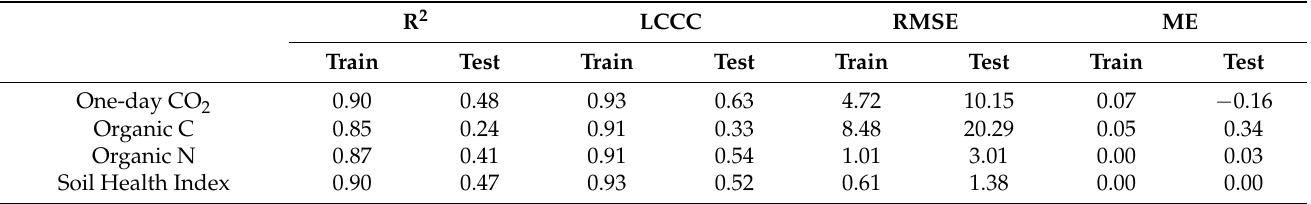
Table 3. Performance evaluation of prediction model on train (75%) and test (25%) dataset. R 2 LCCC